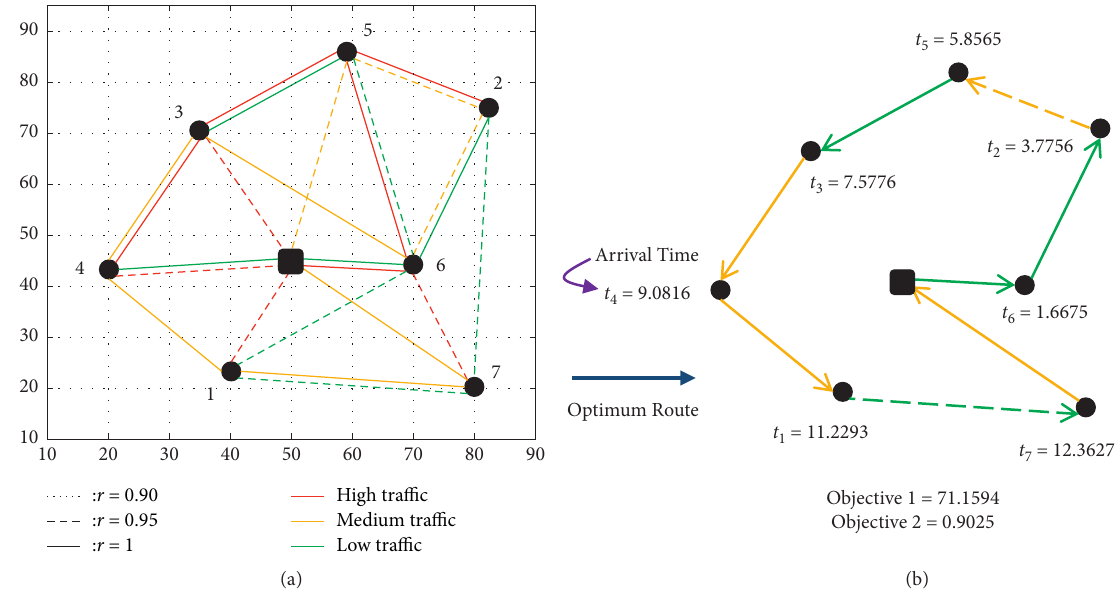
Figure 8: (a) Sample multigraph network; (b) optimum solution.